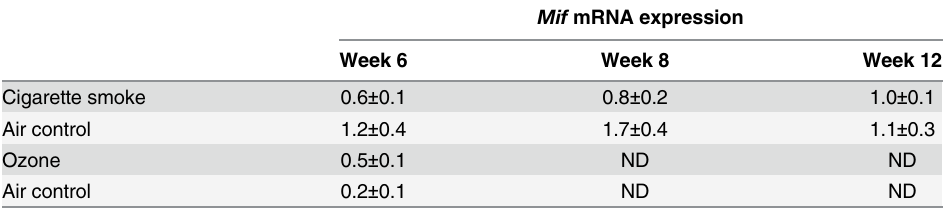
Table 4. Relative Mif mRNA expression in lungs of mouse models of COPD. Äct values of Mif expres- sion in lung tissue relative to Hprt (cigarette model) and 18s (ozone model) expression as measured by RT- qPCR. ND: not